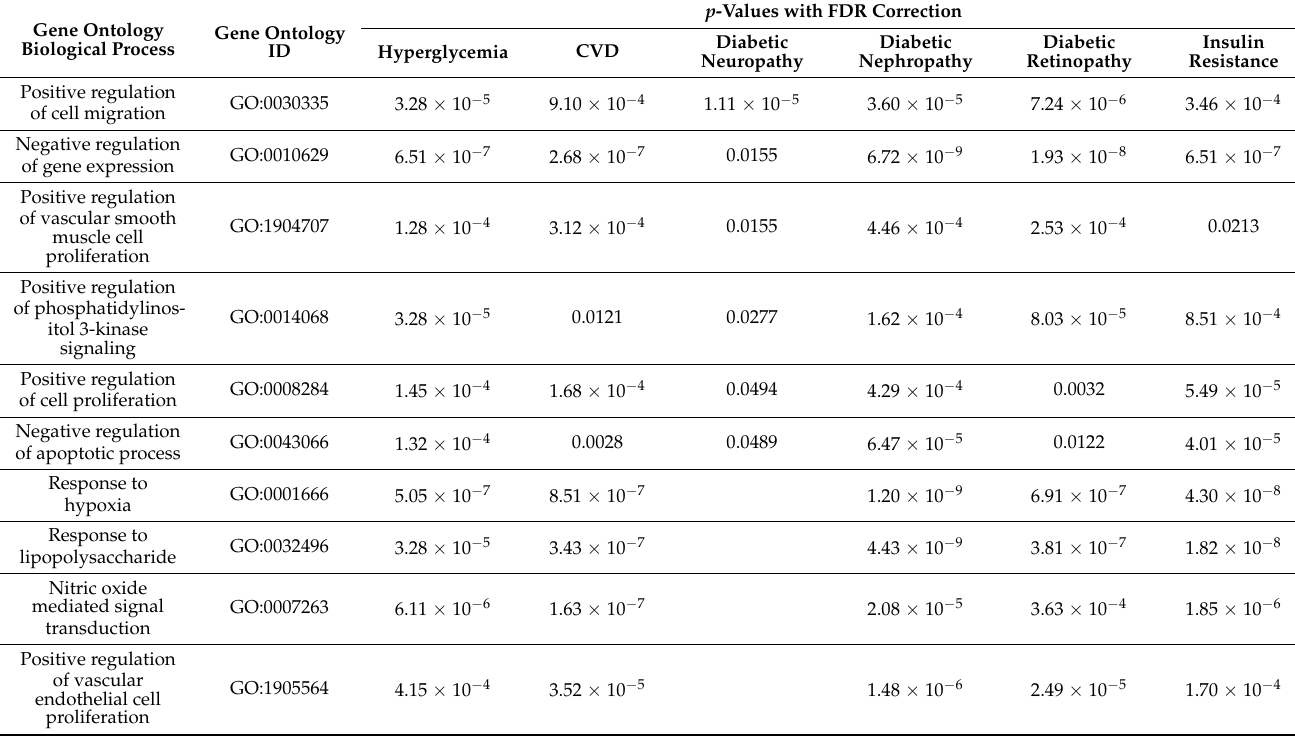
Table 3. The most overrepresented GO biological processes that are common for the sets of genes linked with ACE2 and associated with hyperglycemia, CVD, diabetic neuropathy, diabetic nephropa- thy, diabetic retinopathy, and insulin